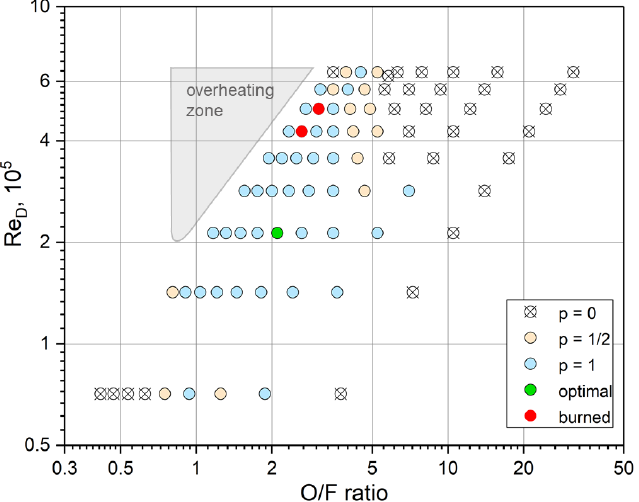
Figure 8. Ignition limits of the swirling oxygen-methane flow in terms of O/F ratio and methane jet Reynolds